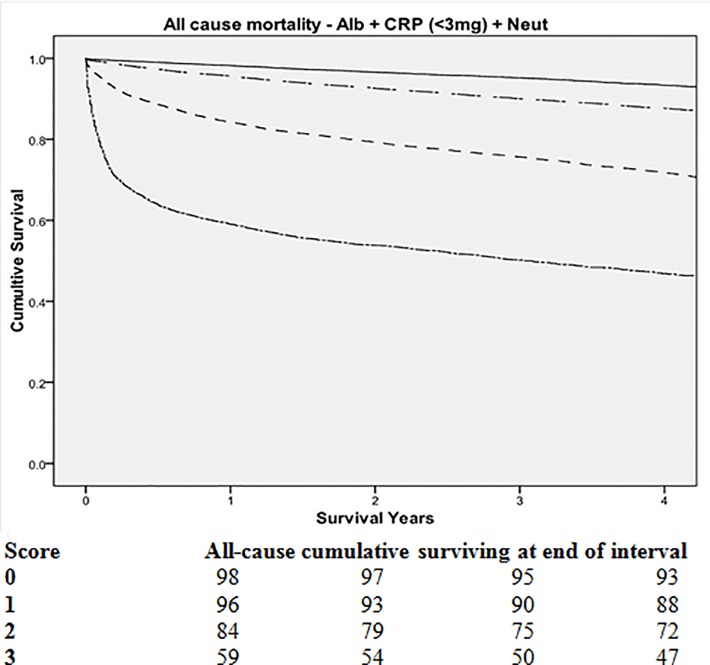
The relationship between cumulative markers of the systemic inflammatory response (including high sensitivity C-reactive protein, albumin and neutrophil count) and survival in an incidental cohort (0-top, solid line; 1-upper separated dot and dash line, 2-middle large dash line, 3-lower close dot and dash line, n = 52 091).